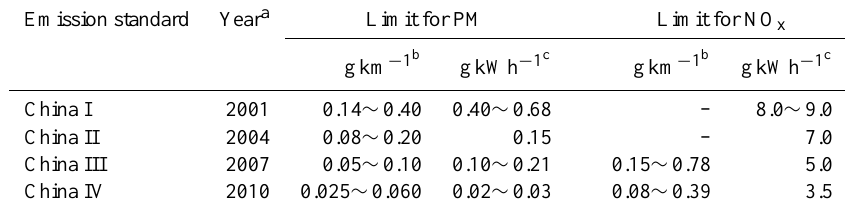
Table 2. Vehicle emission standards and limits for PM and NO x implemented in Guangzhou after